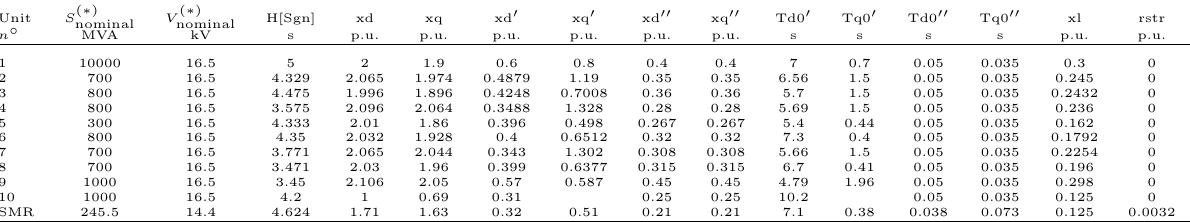
Table A.1. Sixth-order synchronous machine model.